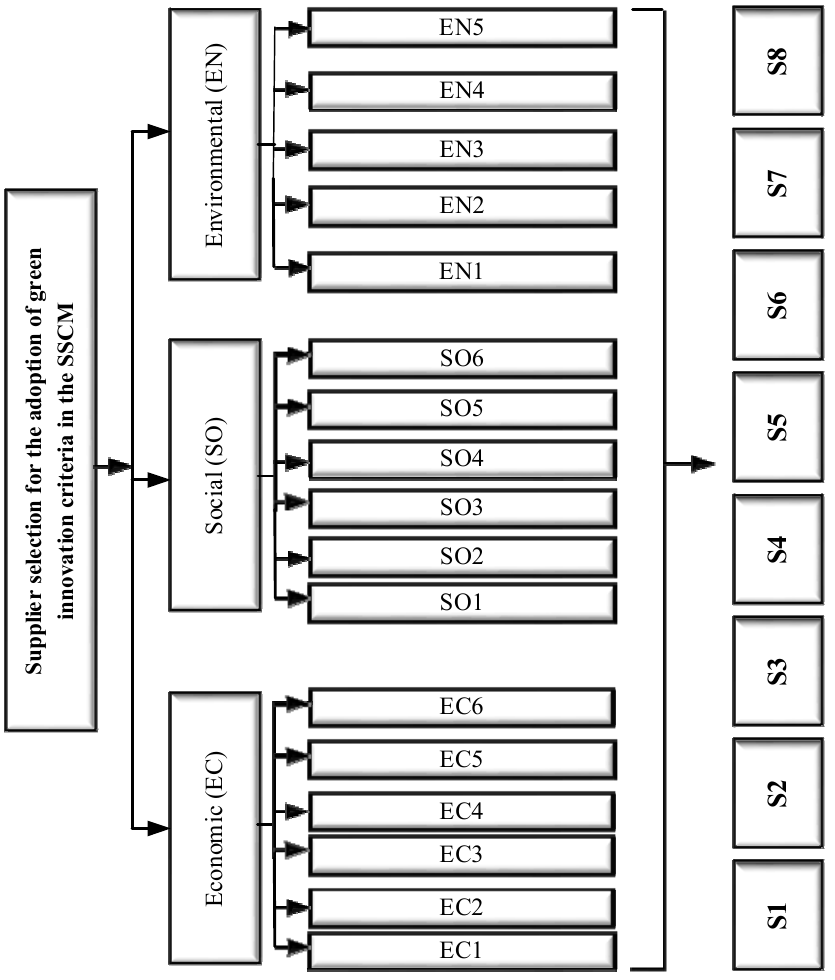
Figure 2. The hierarchically structured decision framework.